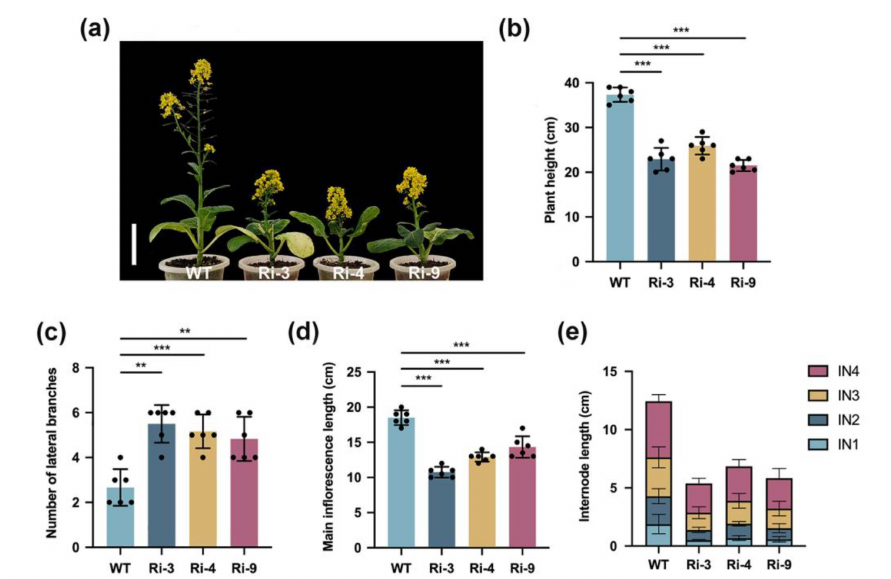
Figure 1. Phenotypic analysis of wild-type and BrCHR39 -silenced plants. ( a ) Comparison of the phenotypes between 8-week-old wild-type and T 2 transgenic plants. Scale bar = 10 cm. ( b – e ) Com- parison of plant architecture-related traits, including plant height ( b ), number of lateral buds ( c ), main inflorescence length ( d ), and internode (IN) length ( e ) between 8-week-old wild-type and T 2 transgenic plants. All values are presented as the means of six replicates ± standard deviation (SD). Significant differences are determined by Student’s t -test (** p < 0.01; *** p <